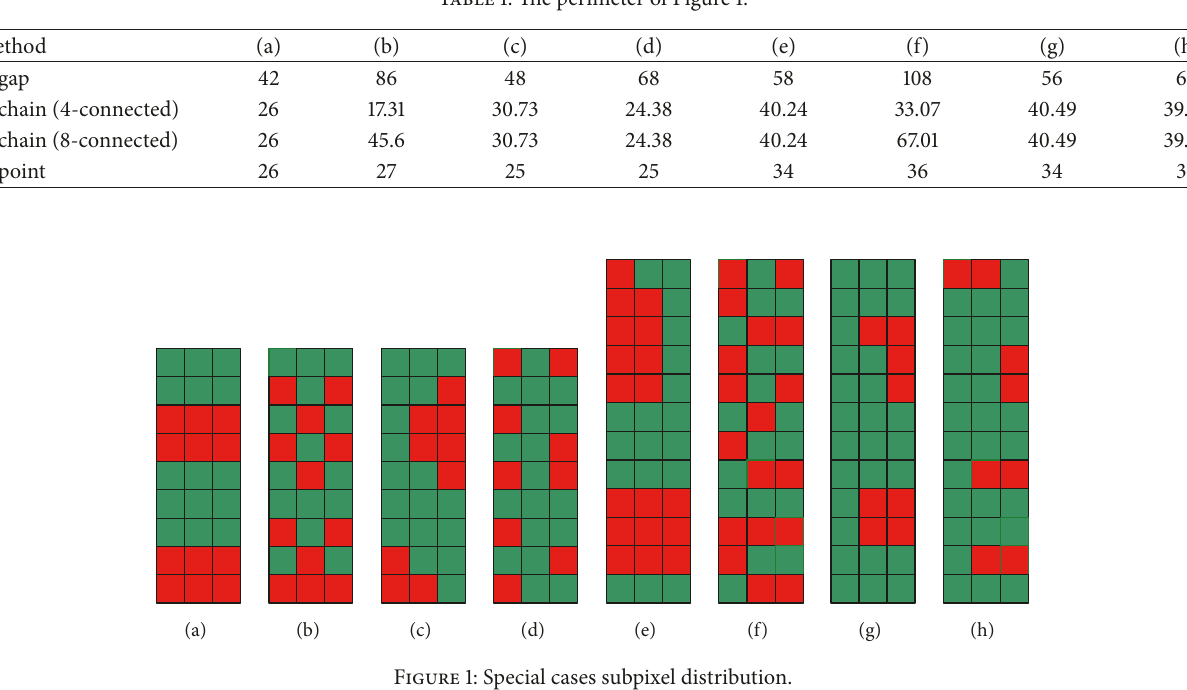
Table 1: The perimeter of Figure 1.